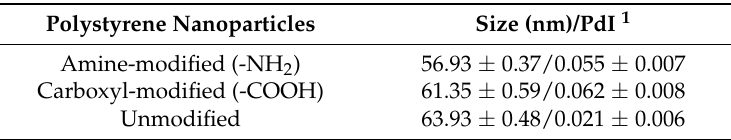
Table 1. Size of polystyrene nanoparticles